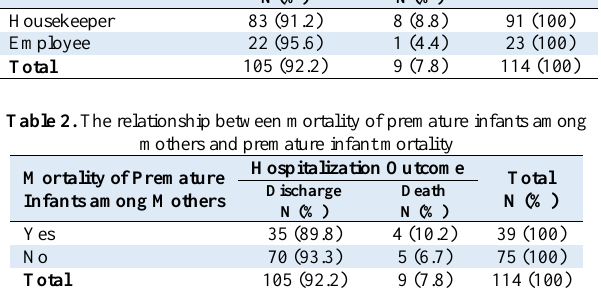
Table 1. The relationship between the employment status of mothers and premature infant mortality Employment Status of Mothers